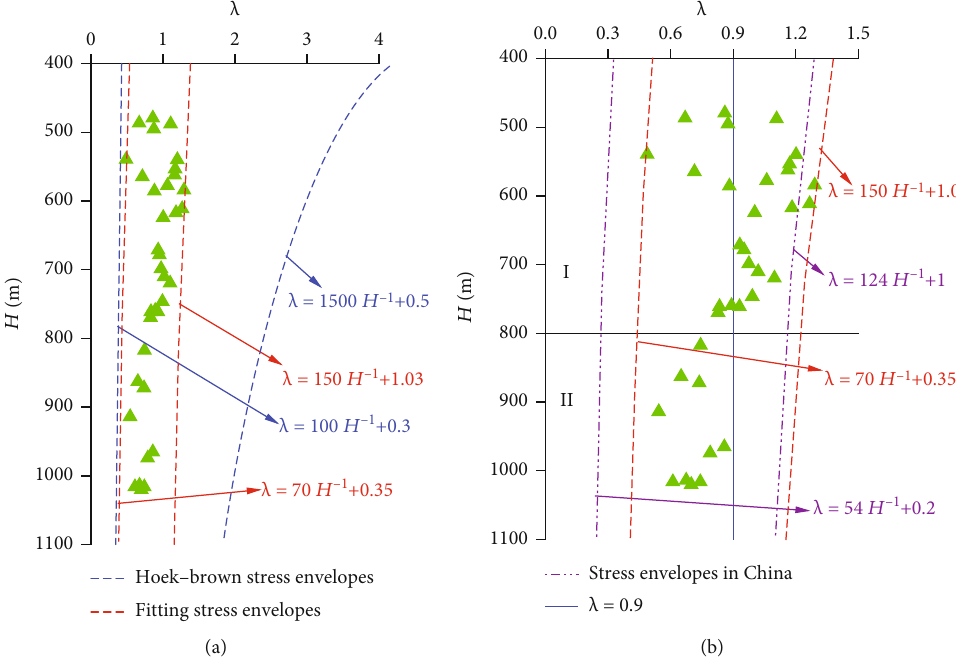
Figure 7: Scatter diagrams of coe ffi cient of lateral stress and burial depth: (a) relationship between the lateral stress coe ffi cient and the Hoek – Brown stress envelope; (b) the relationship between the lateral stress coe ffi cient and the stress envelope in China.